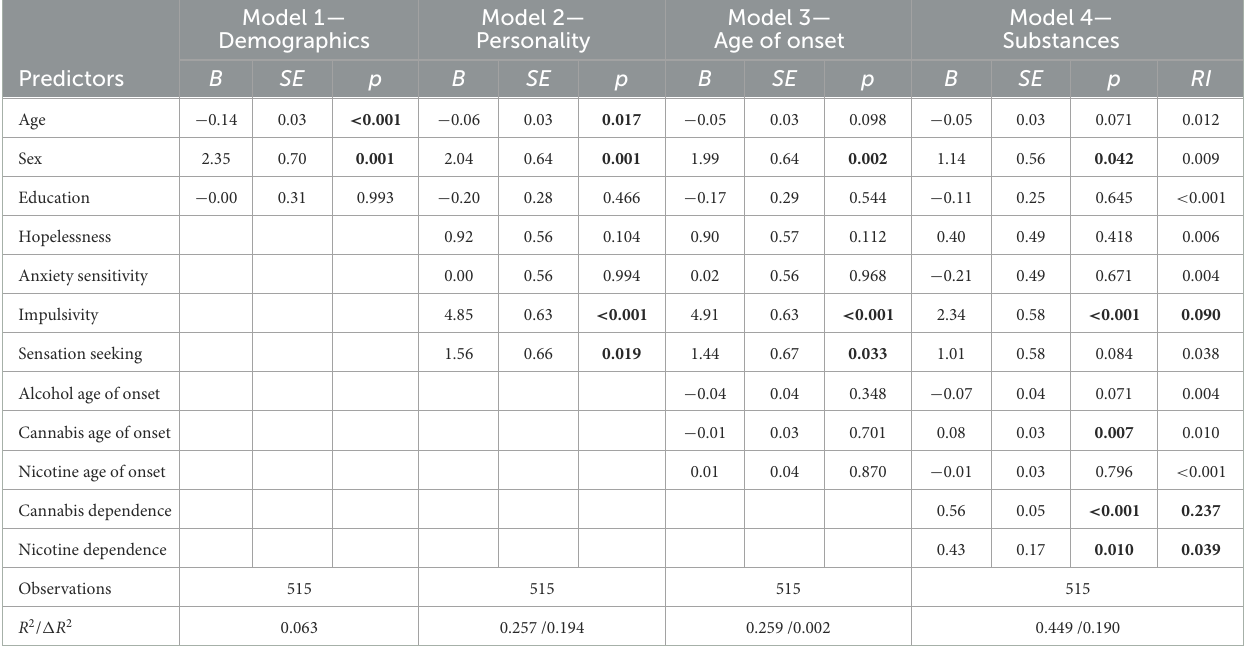
TABLE 1 Hierarchical multiple regression statistics for alcohol